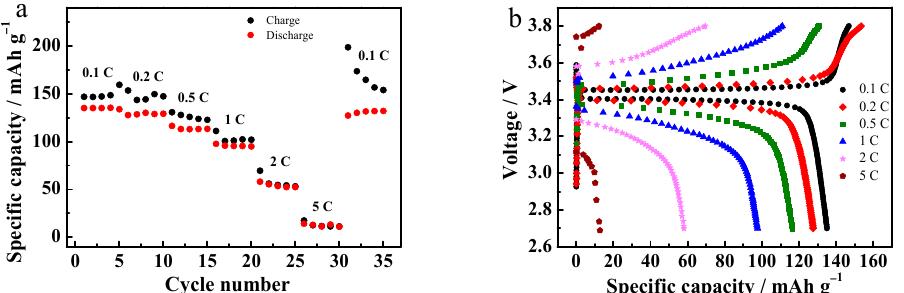
Figure 5. ( a ) Rate performance of the LIBs with TLPEC electrolyte measured with various charge and discharge current densities at 25 °C. ( b ) The first cycle of charge and discharge curves of the LIBs with TLPEC electrolyte under various current densities at 25 °C.